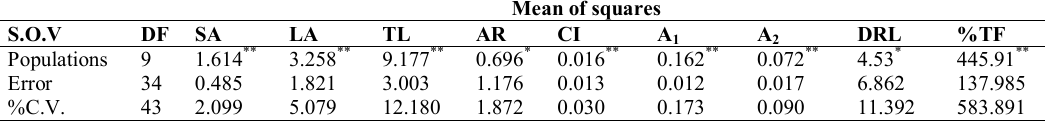
Table 4. The results of variance analysis for karyotypic data based on CRD design